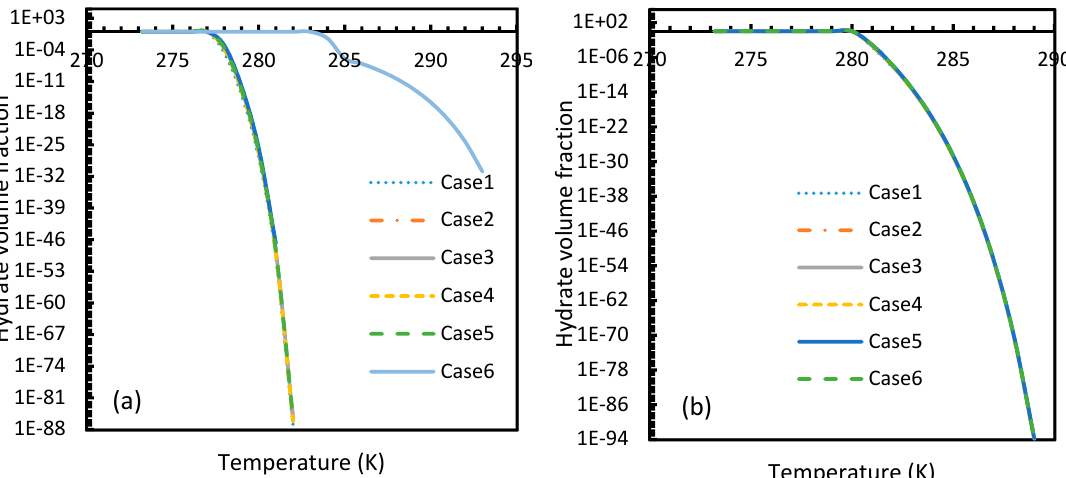
Figure 22. Profiles of hydrate volume fractions at theoretical induction time of CO 2 ( a ) and CH 4 ( b ) under isobaric conditions with reference pressure 30 MPa, calculated through the considered cases, apart from Case 6, from Case 2. The point of non-differentiability is found in case of Case 6 for CO 2 hydrates, indicating relative favorability of CO 2 for hydrate formation at high temperature, while the rest shows early depletion at relatively lower temperatures.